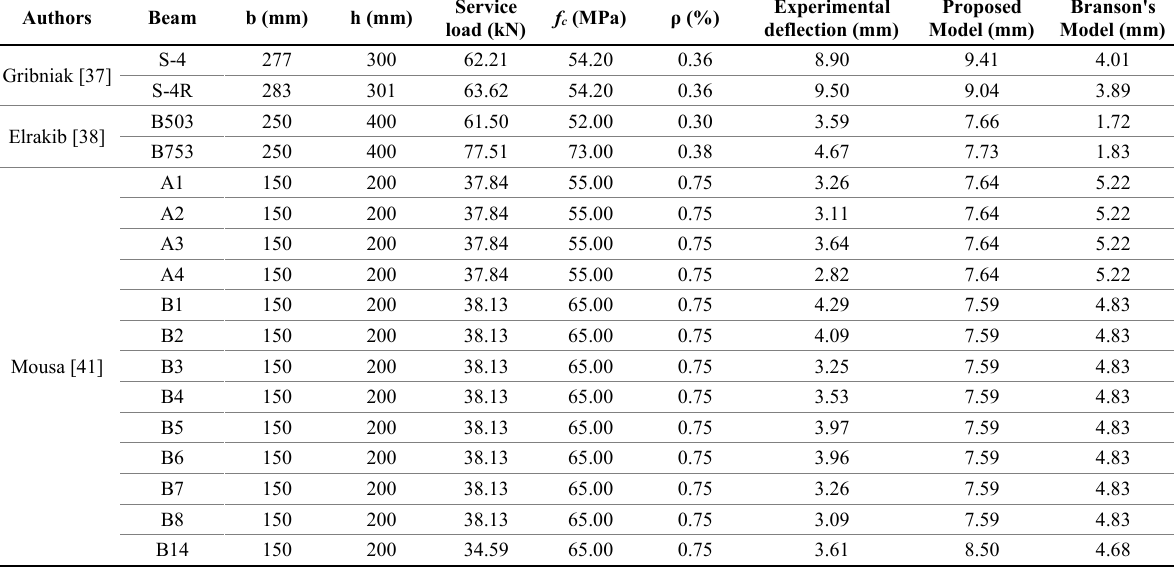
Table A3. Beams data with f c from 50MPa to 90MPa and reinforcement rate from 0 to